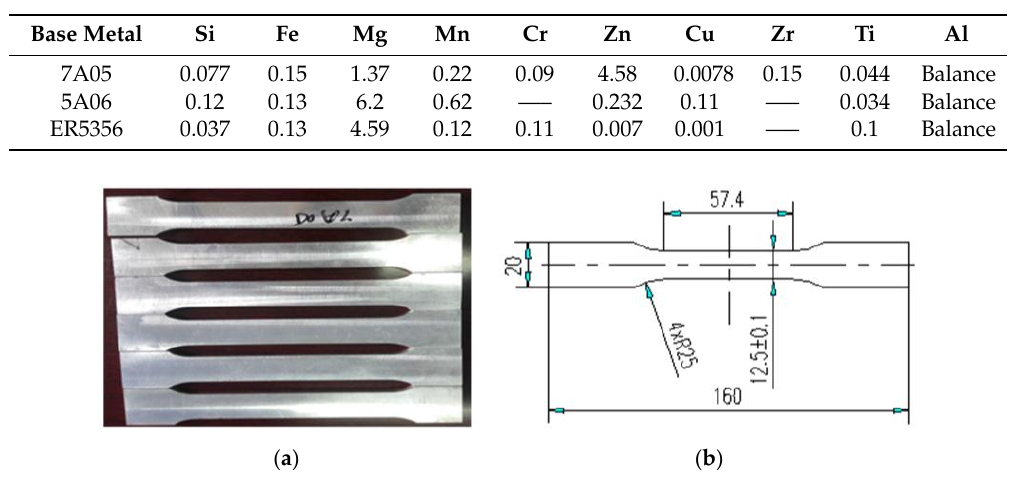
Figure 2. Specimens: ( a ) tensile specimens; ( b ) the dimensions (mm) of the tensile specimens. With the VMH-I04 micro hardness tester according to GB/T 4340.1-2009 [39], the test force was 0.9807 N (100 g) and the distance of two points was around 0.85 mm. Vickers hardness gradient test was conducted and the hardness value was given in